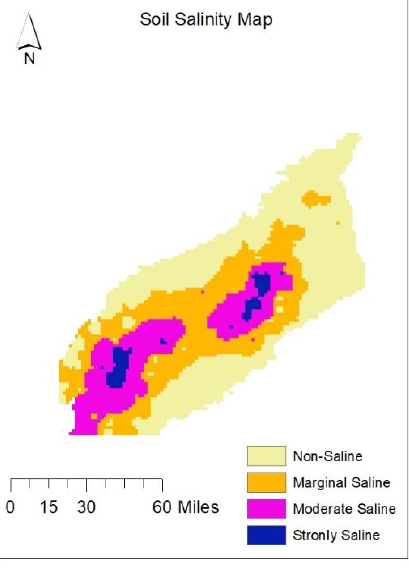
Figure 2: Spatial map of soil